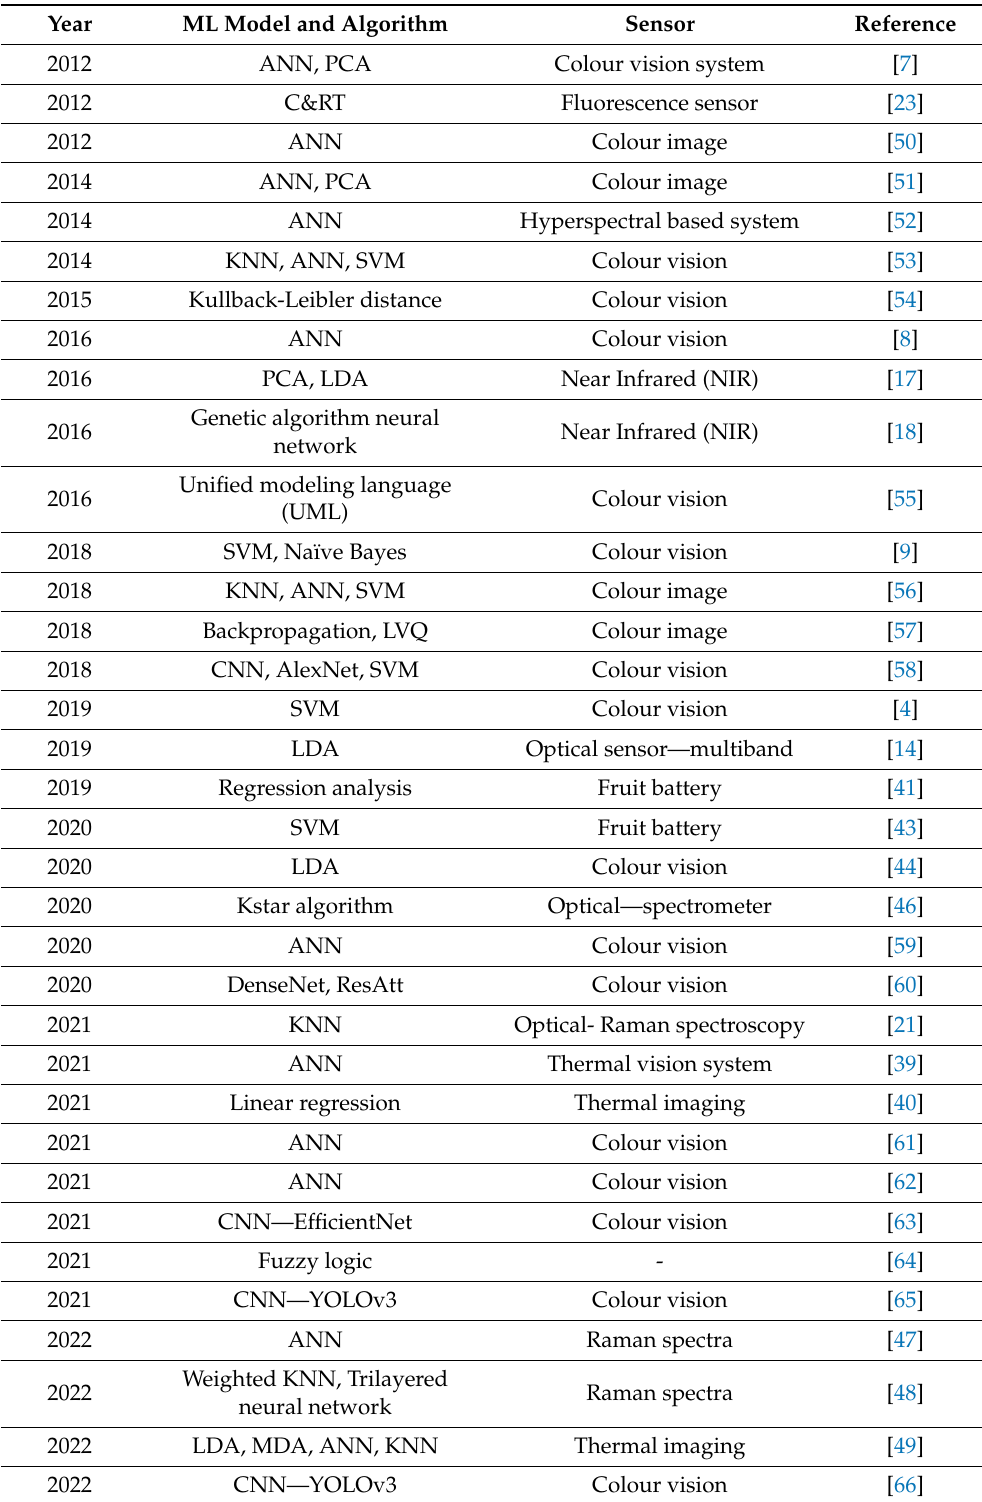
Table 2. Machine learning models and algorithms applied to classify the FFB maturity